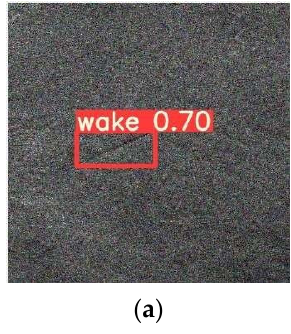
Figure 16. Results of ship wake recognition: ( a ) single target; ( b ) multiple targets; ( c ) nonlinear